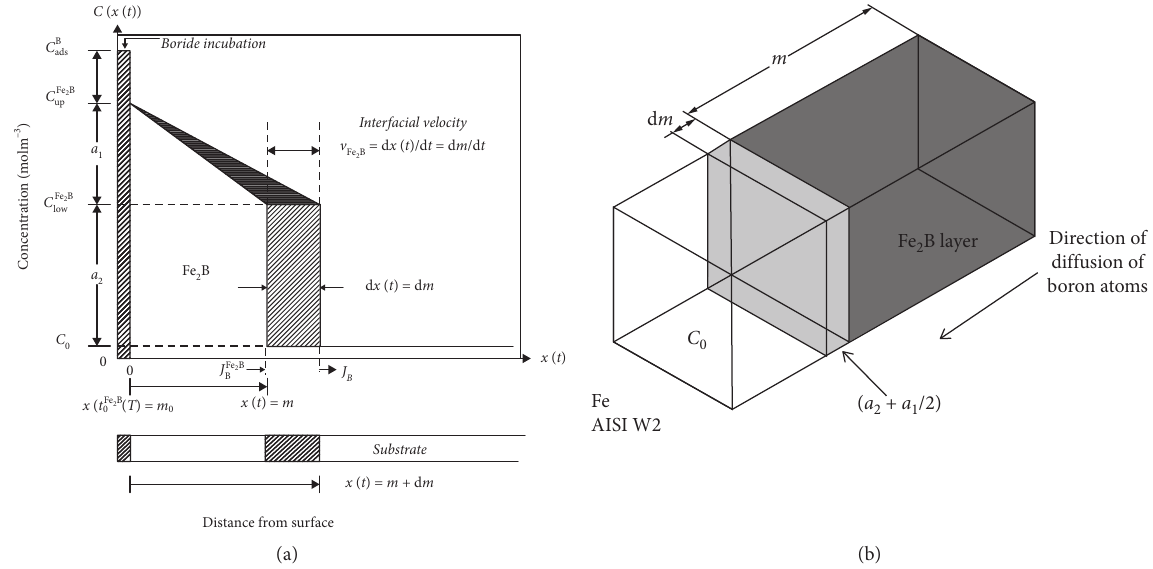
2 B and (b) schematic diagram of the mass